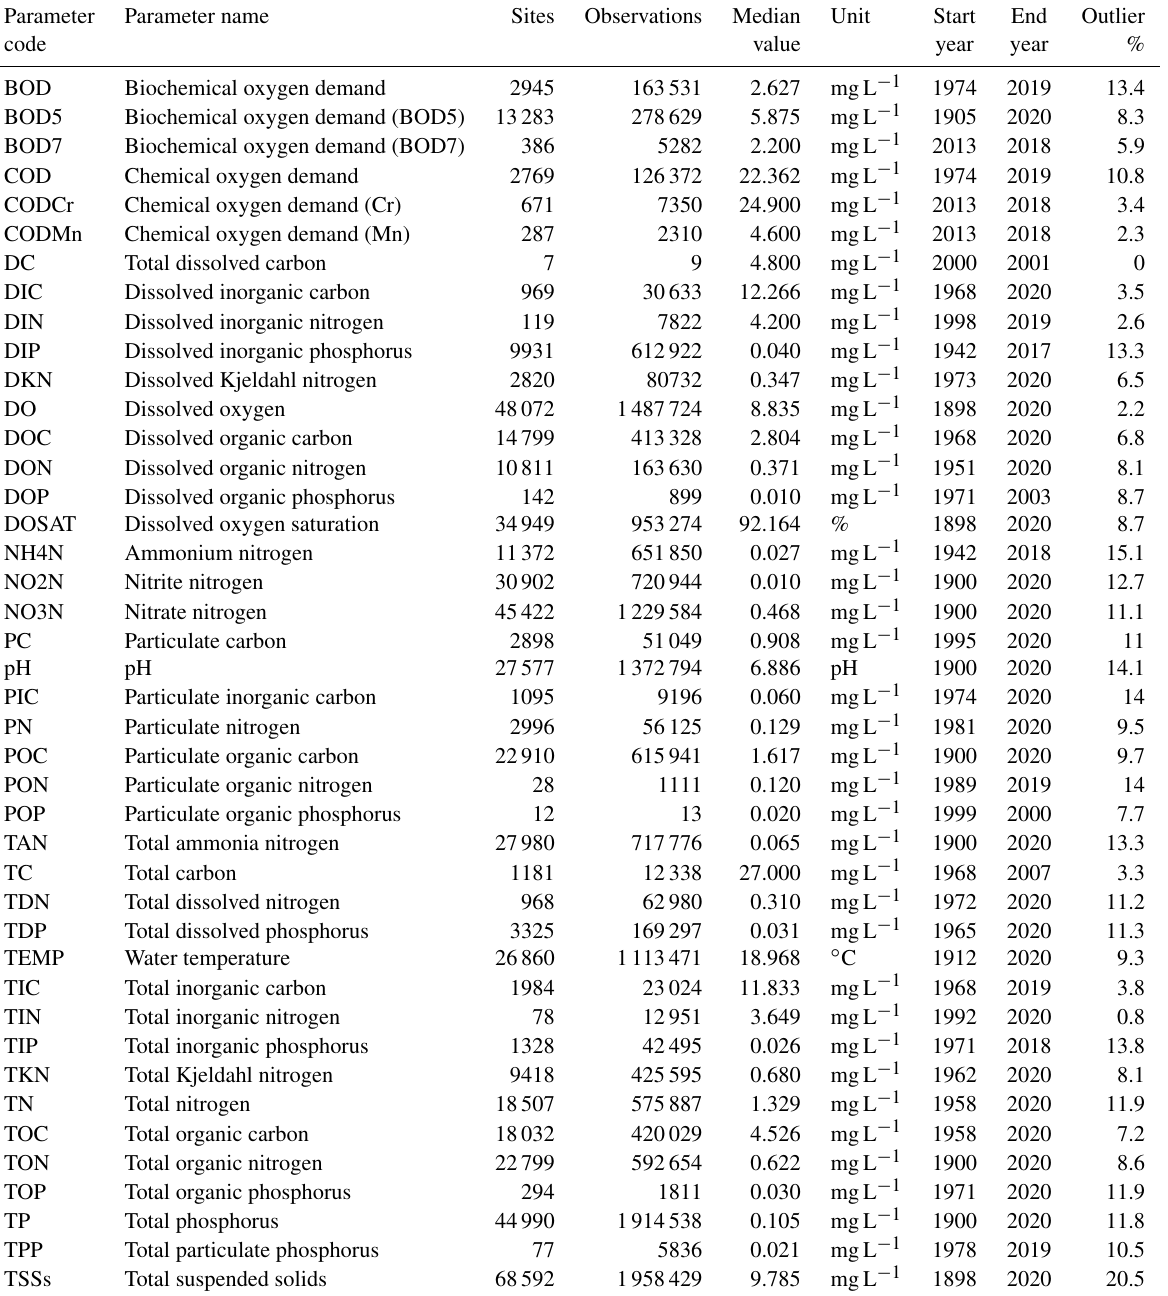
Table 7. GRQA water quality parameter